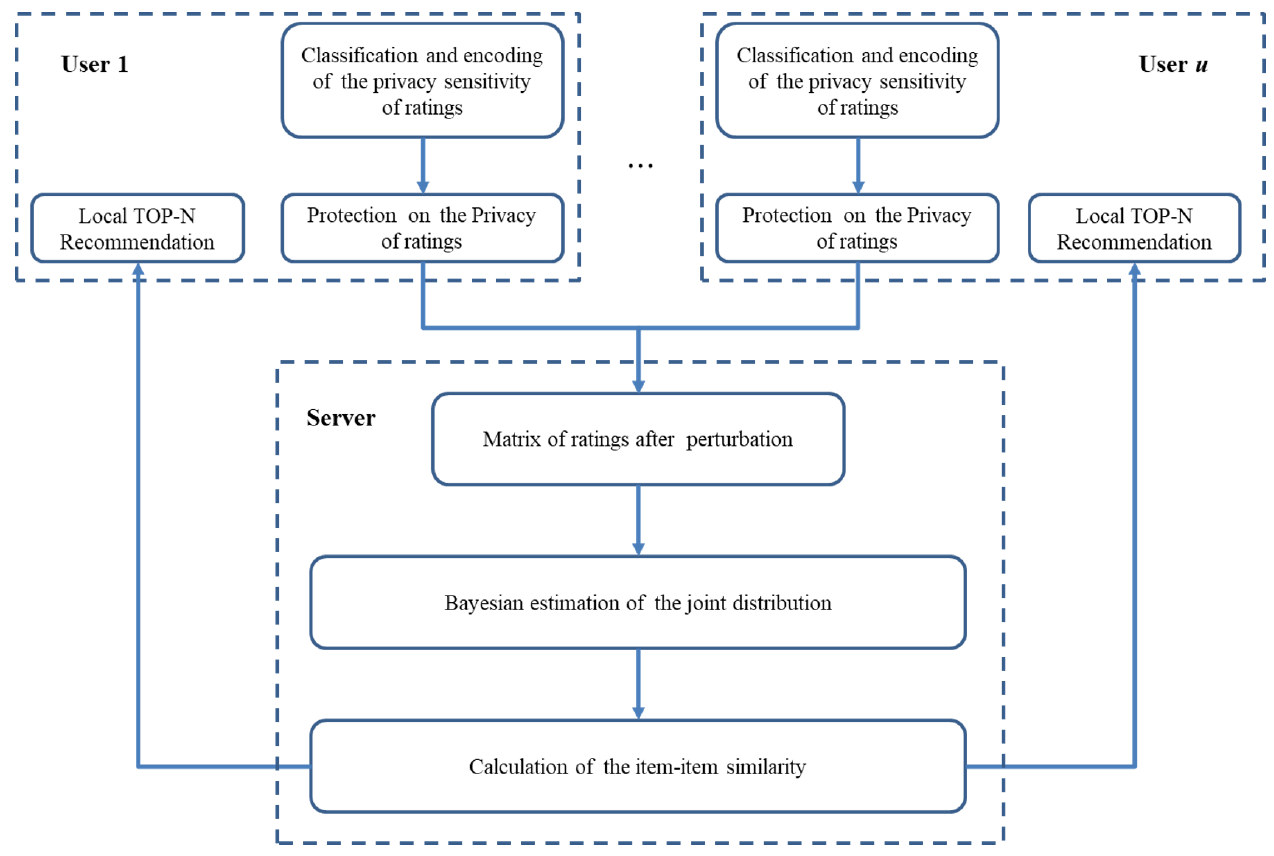
Figure 1. Overview of Algorithmic architecture.